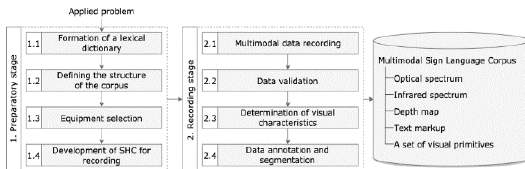
Figure 1. Diagram of the methodology for creating multimodal SL